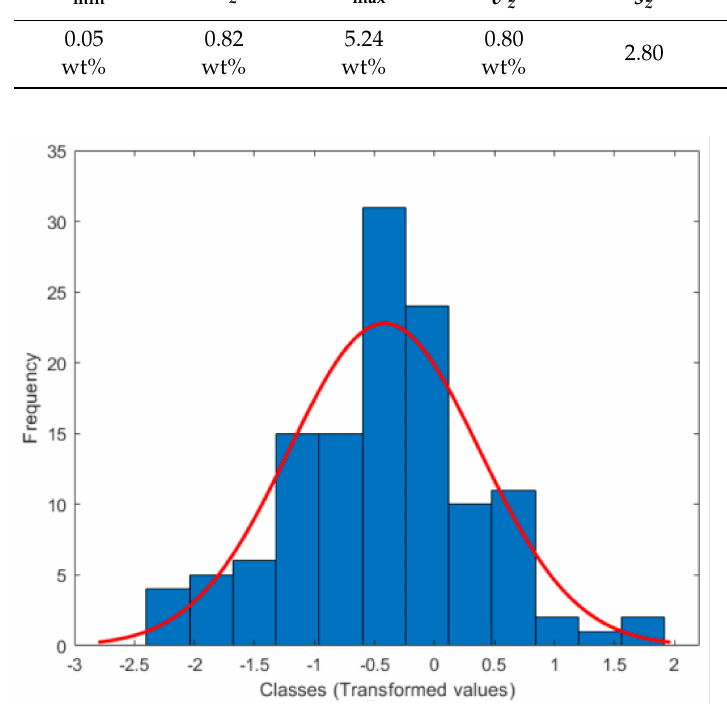
Figure 4. Transformed residuals